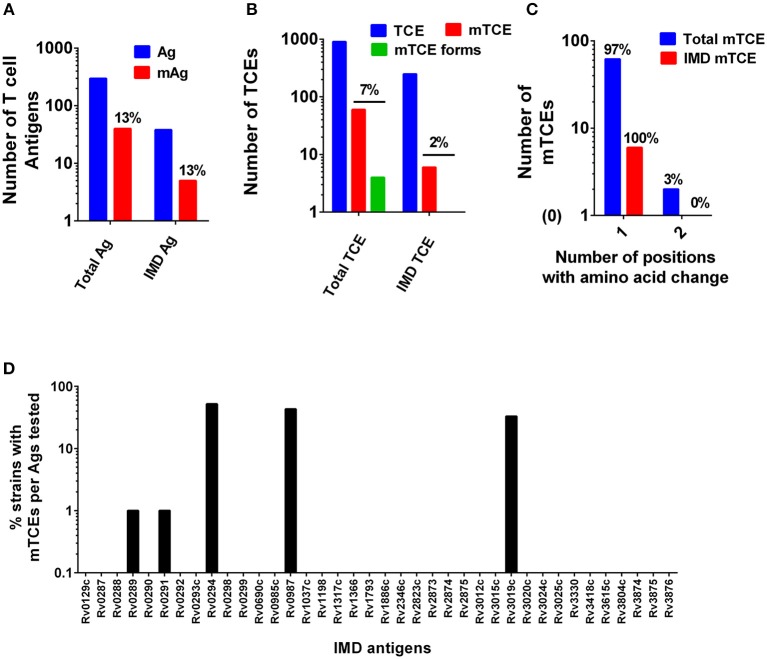
Patterns of mutated antigens (mAg) and mutated epitopes (mTCEs) across 79 Mtb strains. The set of T-cell antigens and epitopes, as well as a subset of immunodominant (IMD) antigens and epitopes, were analyzed based on their nature and locus in the Mtb reference strain H37Rv genome. (A) The total number of reference/parent T cell antigens (blue), the number of mAg (red), and the number of parent immunodominant antigens and mutants analyzed is shown. (B) The total number of reference/parent T-cell epitopes (blue), the number of mTCE (red), and the number of immunodominant parent T-cell epitopes and mutants are shown. The green bar identifies mTCE with two or more mutant forms. (C) The number of mTCE with one vs. two amino acid changes is shown (blue bar represents total mTCE; red bar immunodominant mTCE). (D) Representation of mTCEs in immunodominant antigens: A total of 33 of 82 antigens identified by Lindestam et al. (58) was confirmed to be represented in the list of 298 reference antigens analyzed. Bars identify frequency of five mutated immunodominant antigens in 79 Mtb strains.